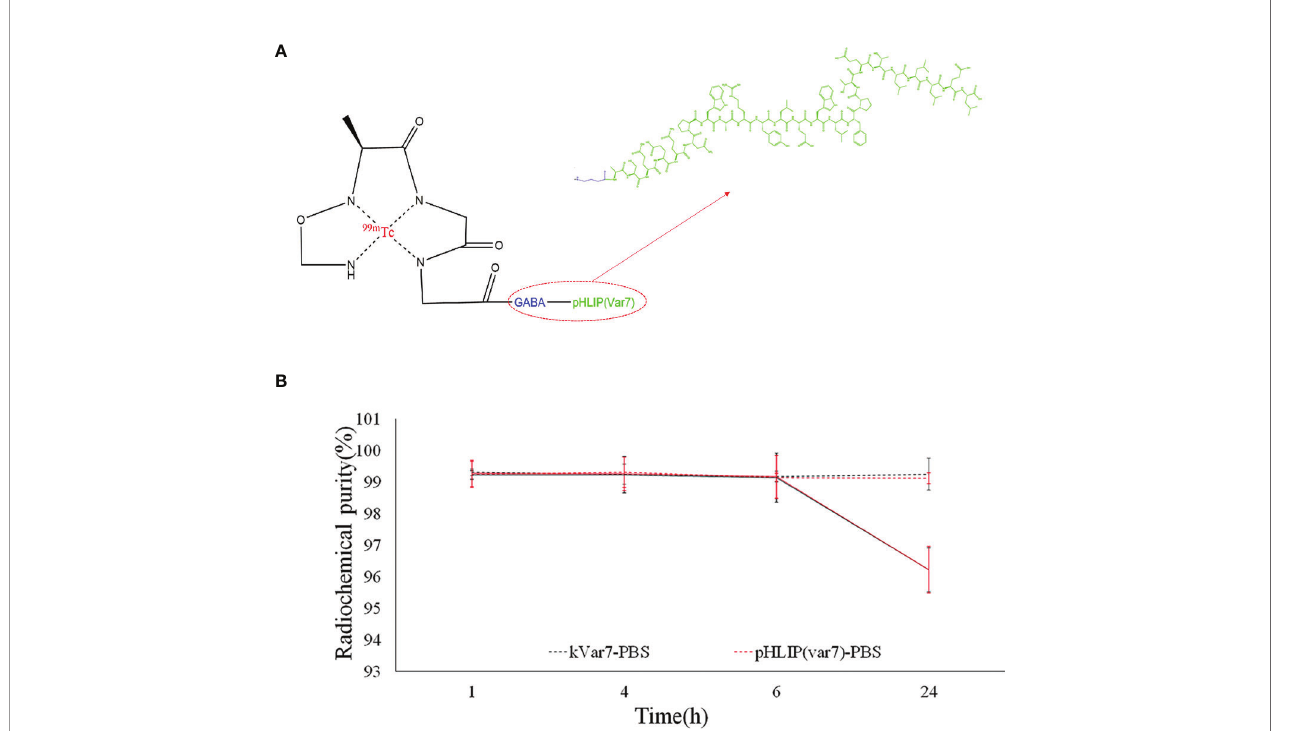
FIGURE 2 | (A) N4 structure of 99m Tc-pHLIP (Var7). (B) Stability of 99m Tc-pHLIP (Var7) and 99m Tc-kVar7 in PBS at room temperature and in fresh human serum at